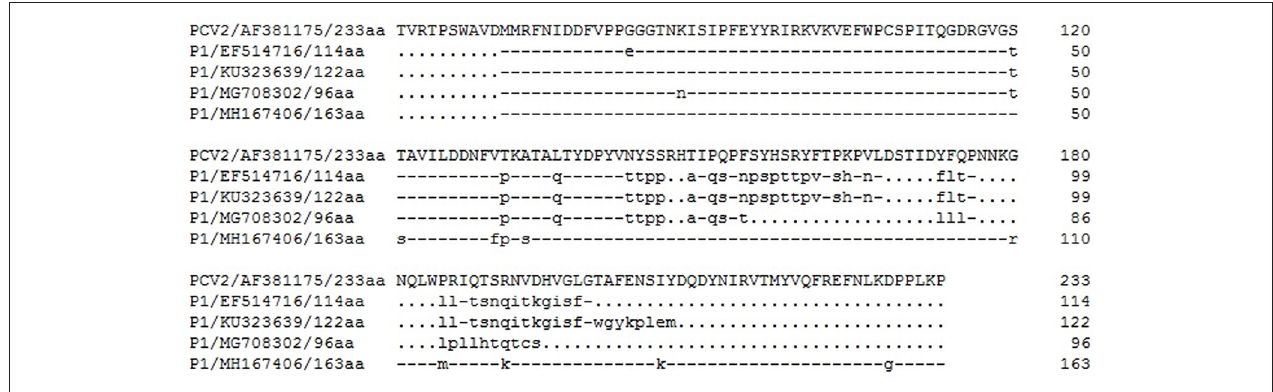
FIGURE 4 | Sequence alignment of the deduced amino acid sequences of the capsid proteins of representative porcine circovirus type 2 (PCV2) and porcine circovirus-like virus P1. All strains are marked by accession no. and by amino acid length of the protein. The diagram was generated using DNAman 7.0 software. Dashes represent amino acids that are identical to those of the PCV2. Dots stand for the deleted amino acids compared with